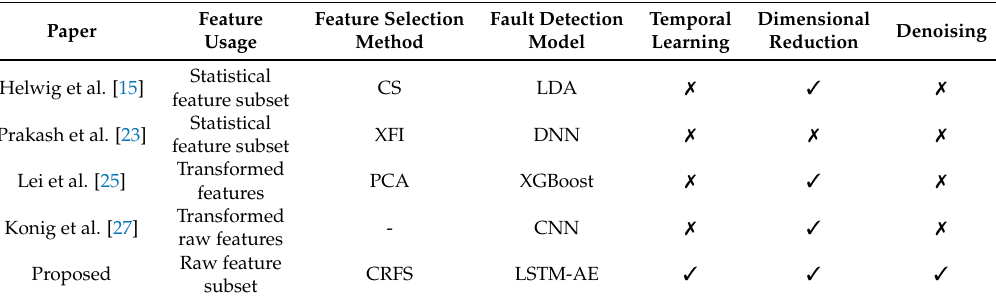
Table 3. Comparison with related